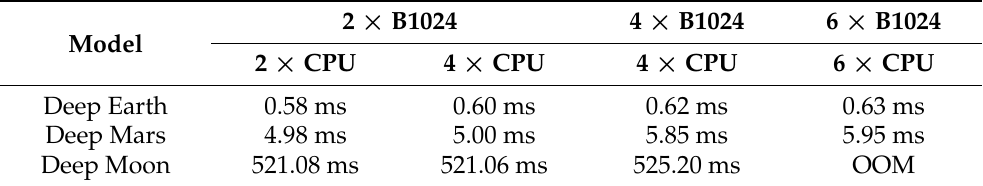
Table 13. Single-Stream benchmark results (90-percentile latency bound) for B1024 DPU architecture.